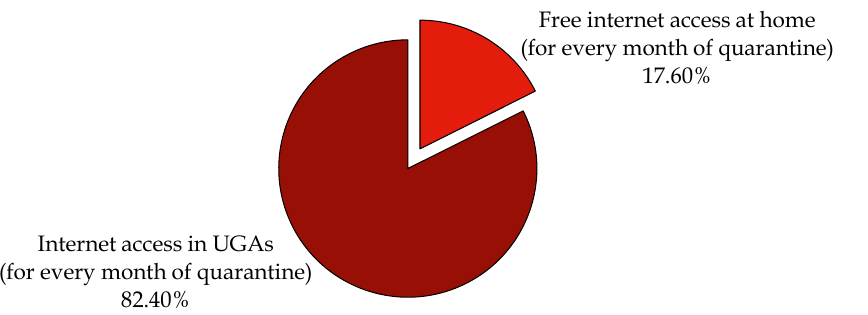
Figure 12. Responses on the selection of trade ‐ off between two options considering lockdown measures against the spread of COVID ‐ 19. Research question: “Which of the following 2 options would you choose in case of restriction measures (quarantine) for stopping the spread of COVID ‐ 19?”